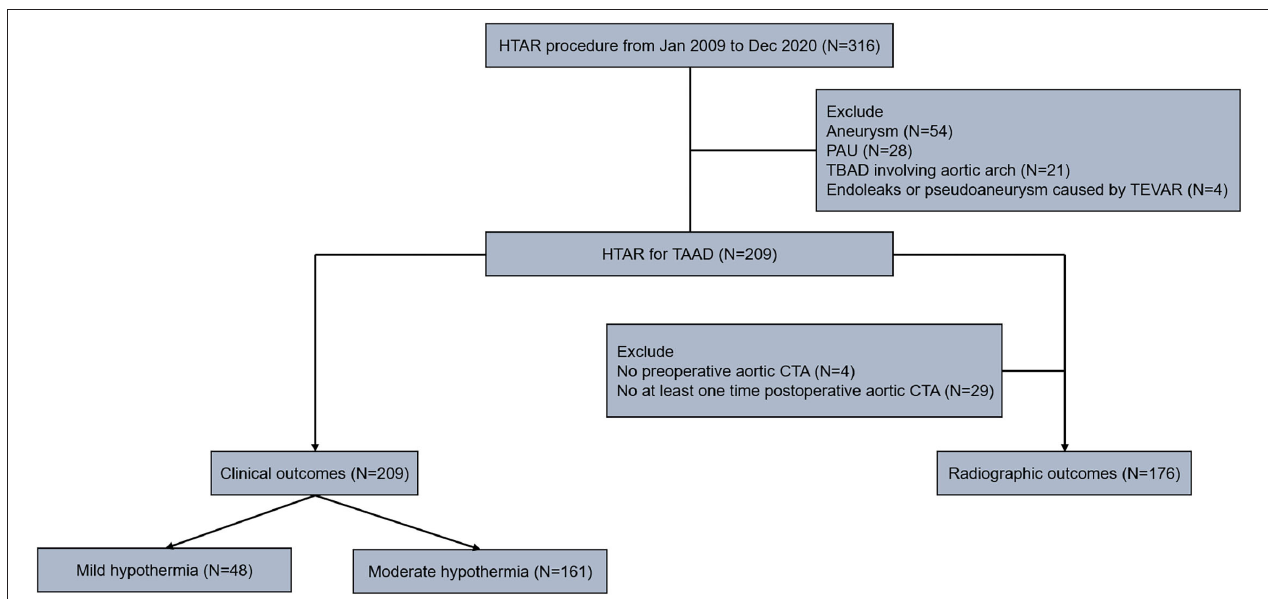
FIGURE 1 | Flow diagram of the study cohort. Two hundred and nine patients who underwent HTAR for TAAD from Jan 2009 to December 2020 were retrospectively analyzed. For analyzing the clinical outcomes, all patients were stratified into mild ( N = 48) and moderate ( N = 161) hypothermia group depending on the lowest nasopharyngeal temperature (30 ◦ C). One hundred and seventy six patients who underwent preoperative and at least one-time postoperative aortic CTA examination in our institute simultaneously were included for analyzing the radiographic outcomes. CTA, computed tomography angiography; HTAR, hybrid total arch replacement; TAAD, type A aortic